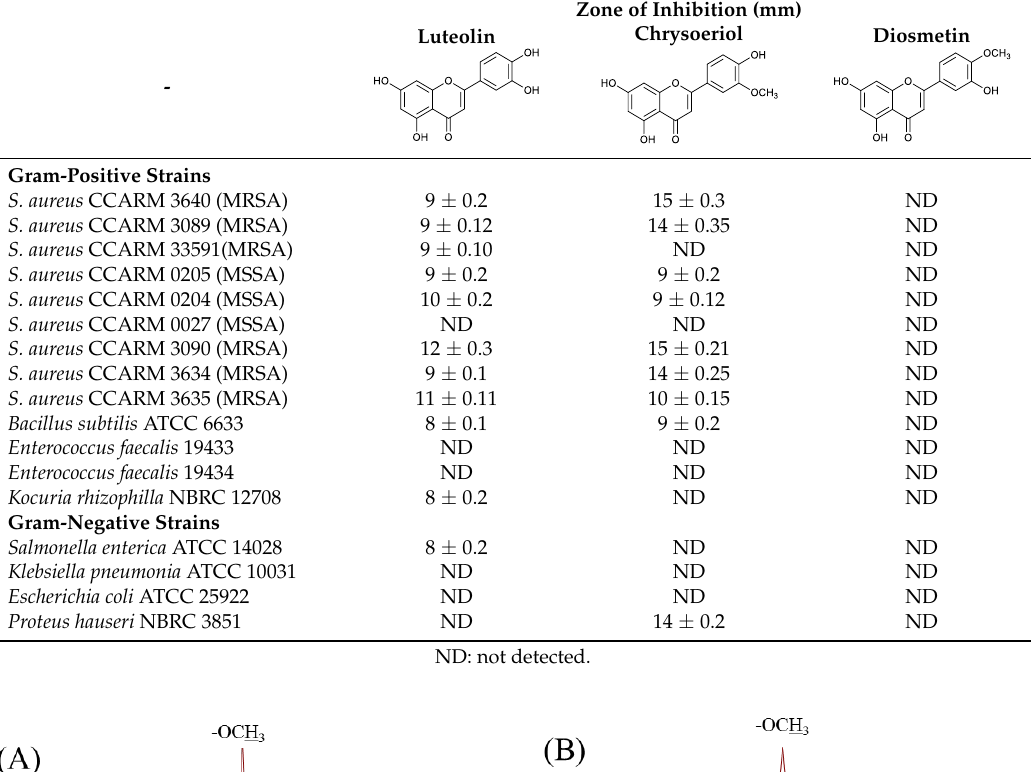
Table 2. Antibacterial activities test against Gram-positive and Gram-negative bacteria via disc diffusion assay. The zone of inhibition (diameter) due to luteolin, diosmetin, and chrysoeriol against different pathogens is noted in mm.